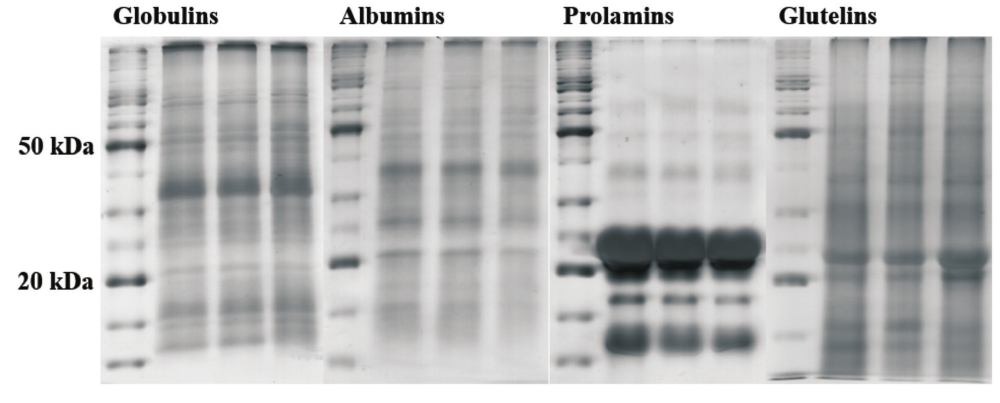
Figure 1 - Profile of grain protein fractions of three pearl millets on SDS-polyacrylamide gels (S -standard, ENA1, ENA2 and BRS -BRS1501 – pearl millet cultivars).